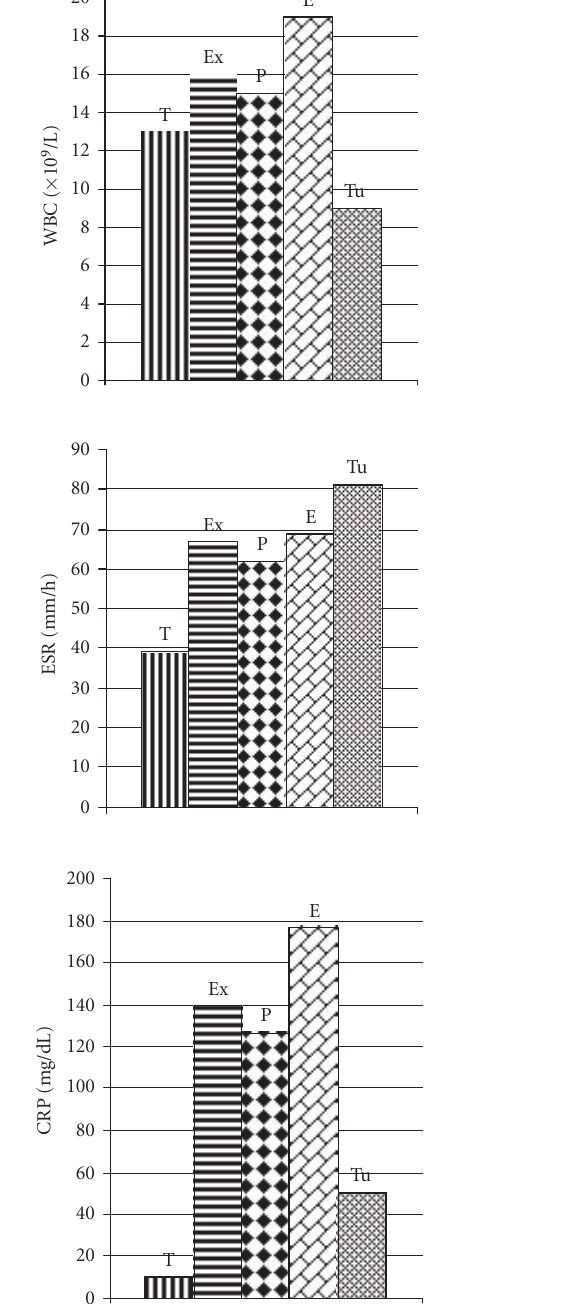
Figure 2. The levels of blood acute phase reactants in the study groups.